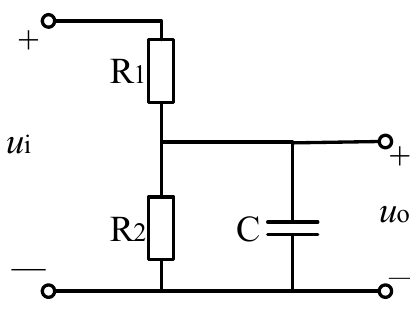
Figure 4. Circuit of the low-pass filter.